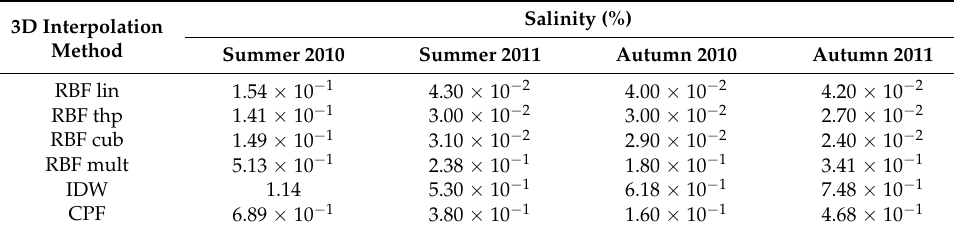
Table 4. The average MREs of different interpolation methods with in situ salinity.